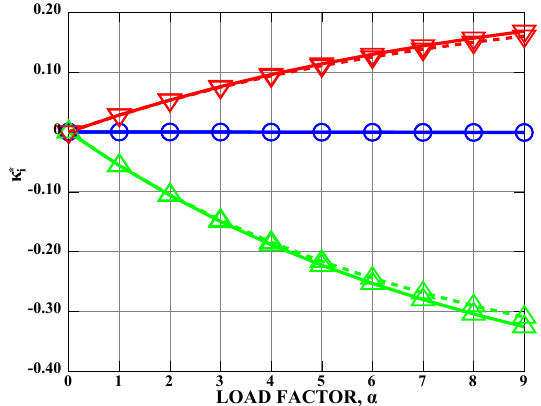
( (cid:13) ), κ ∗ ( 4 ), κ ∗ ( 5 ). 1 2 3